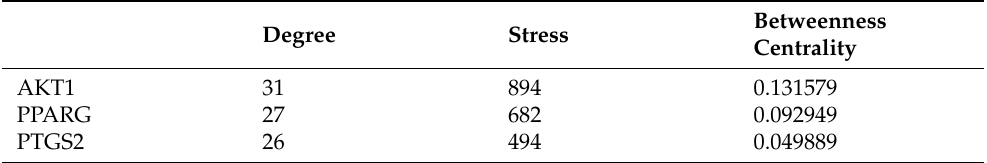
Figure 2. ( A ) Full protein–protein interaction network of 41 hyperlipidemia-related target genes from the herbal combination. ( B , C ) Functional cluster of full PPI network created from MCODE of Cytoscape. Table 2. Network parameters analyzed from the total PPI